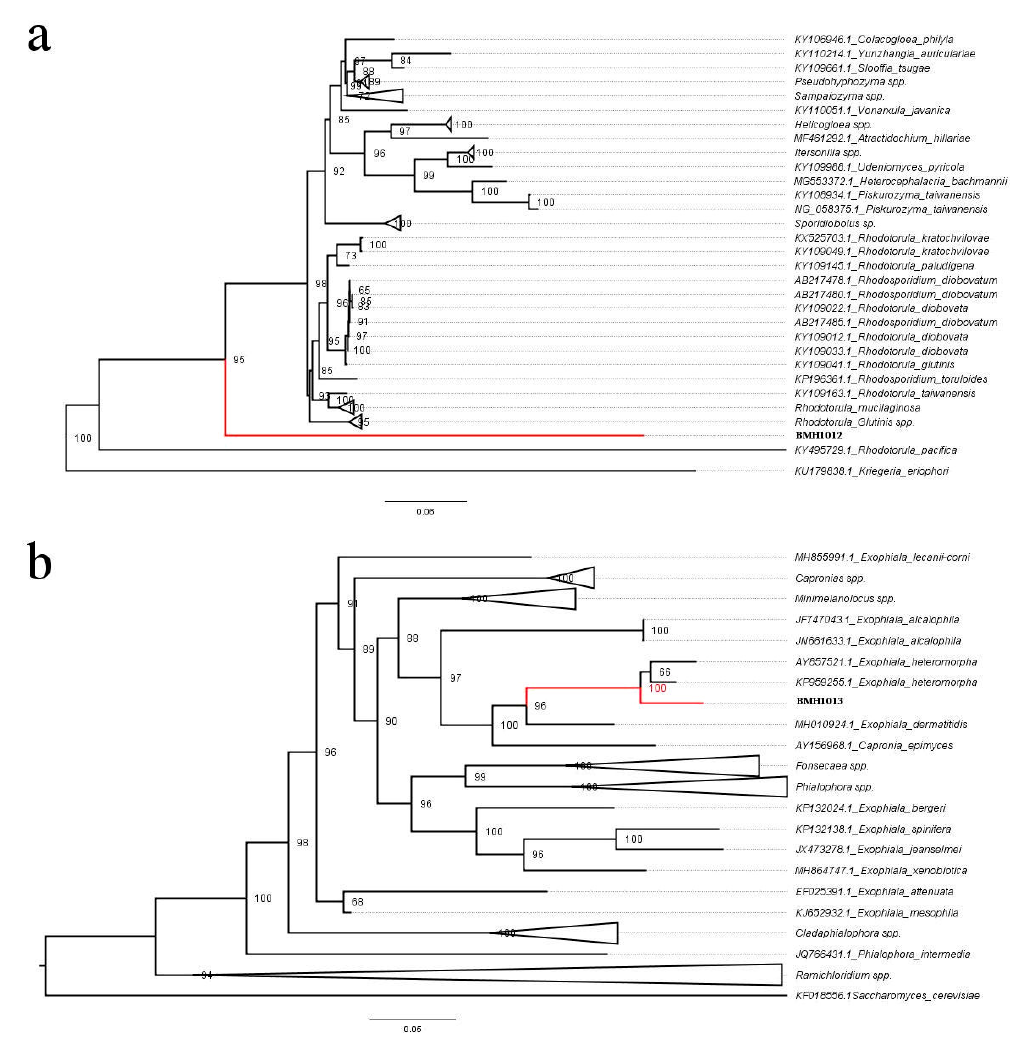
Figure 2. Evolutionary relationships of the Cunduacán isolated strains. ( a ) Phylogenetic relationships of strain BMH1012 with the Rhodotorula genus. and. ( b ) Phylogenetic relationships of strain BMH1013 with the Exophiala genus. The percentage indicated in the branches are the values obtained from the bootstrapped trees.